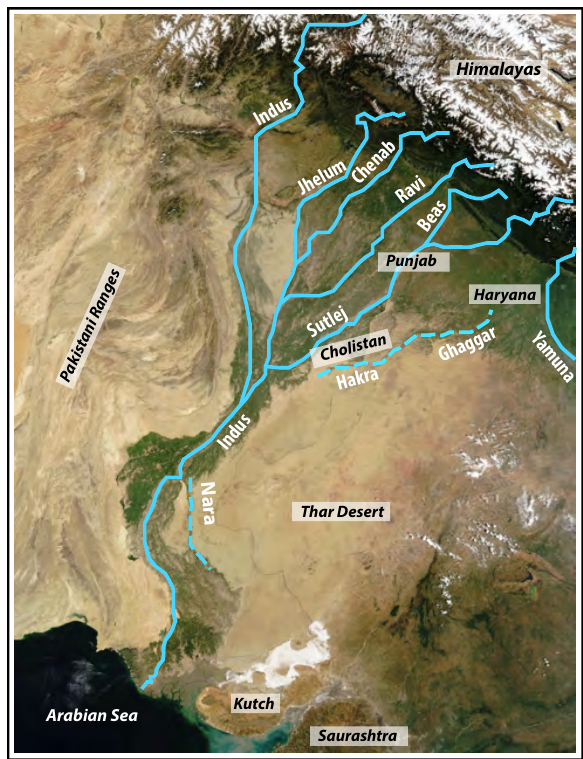
Figure 2. Geographical regions and rivers of the Indus domain dis- cussed in